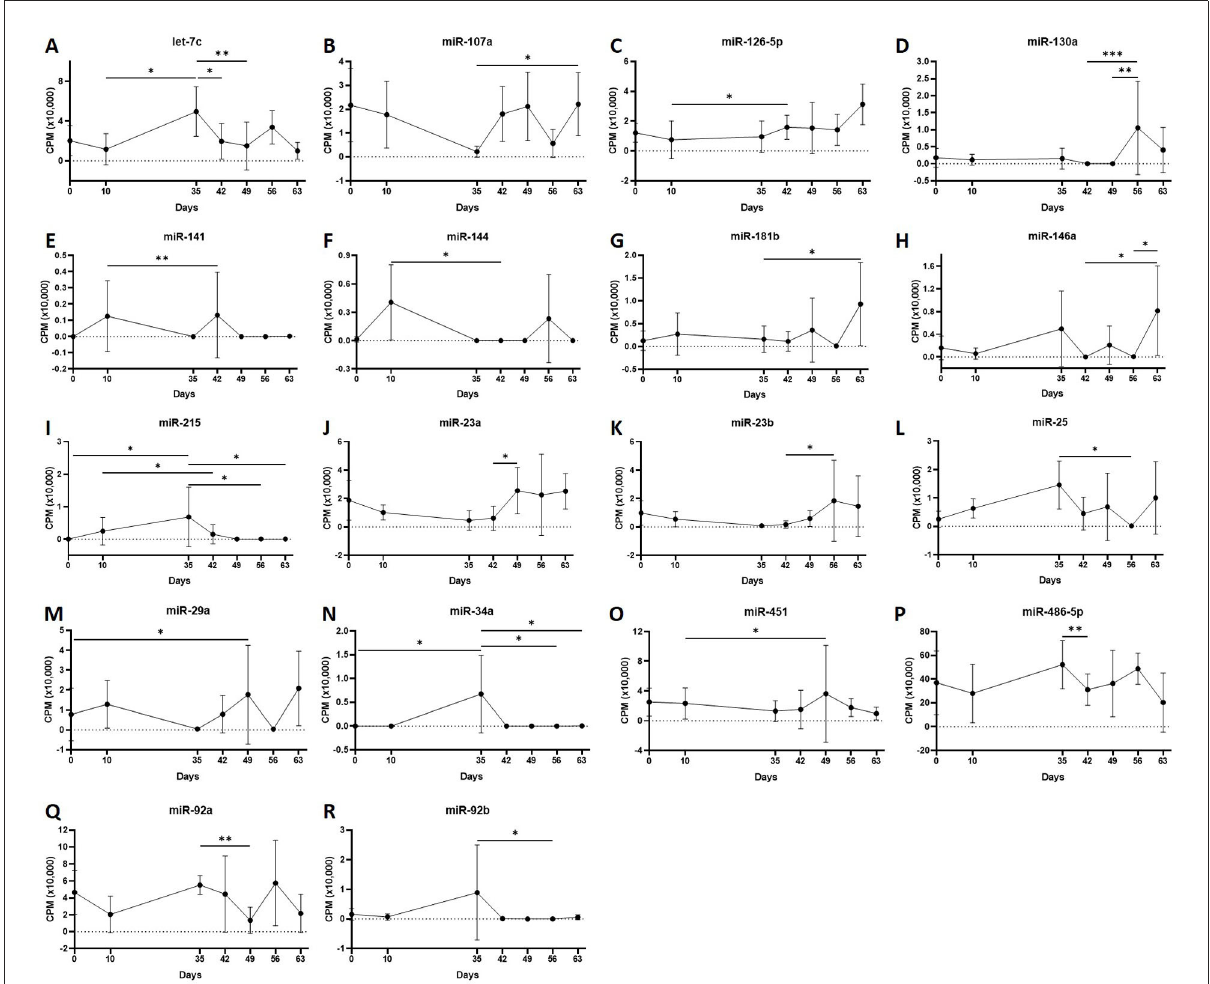
FIGURE5 (A–R) Differentially expressed miRNAs isolated from plasma-derived extracellular vesicles following small RNA sequencing. Individual panels for 18 miRNAs differentially expressed using pairwise comparisons of all the six time points (days 0, 35, 42, 49, 56, and 63), miR, eca-miR, n = 4 horses. Error bars ± 1 standard deviation. * p < 0.05, ** p < 0.01, and *** p <